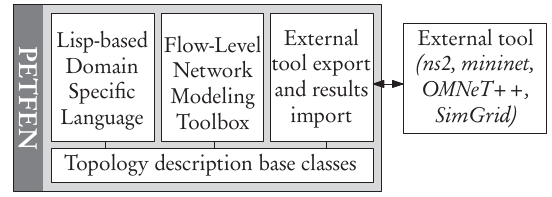
Figure 1: Architecture of